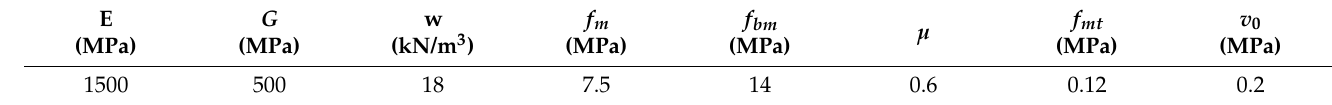
Figure 3. Front and side views of the benchmark masonry building (unit: m). Table 2. Masonry mechanical properties of Case B configuration: elastic modulus 𝐸 , shear modulus 𝐺 , specific weight 𝑤 , masonry compressive strength 𝑓 (cid:3040) , brick compressive strength 𝑓 (cid:3029)(cid:3040) , mortar